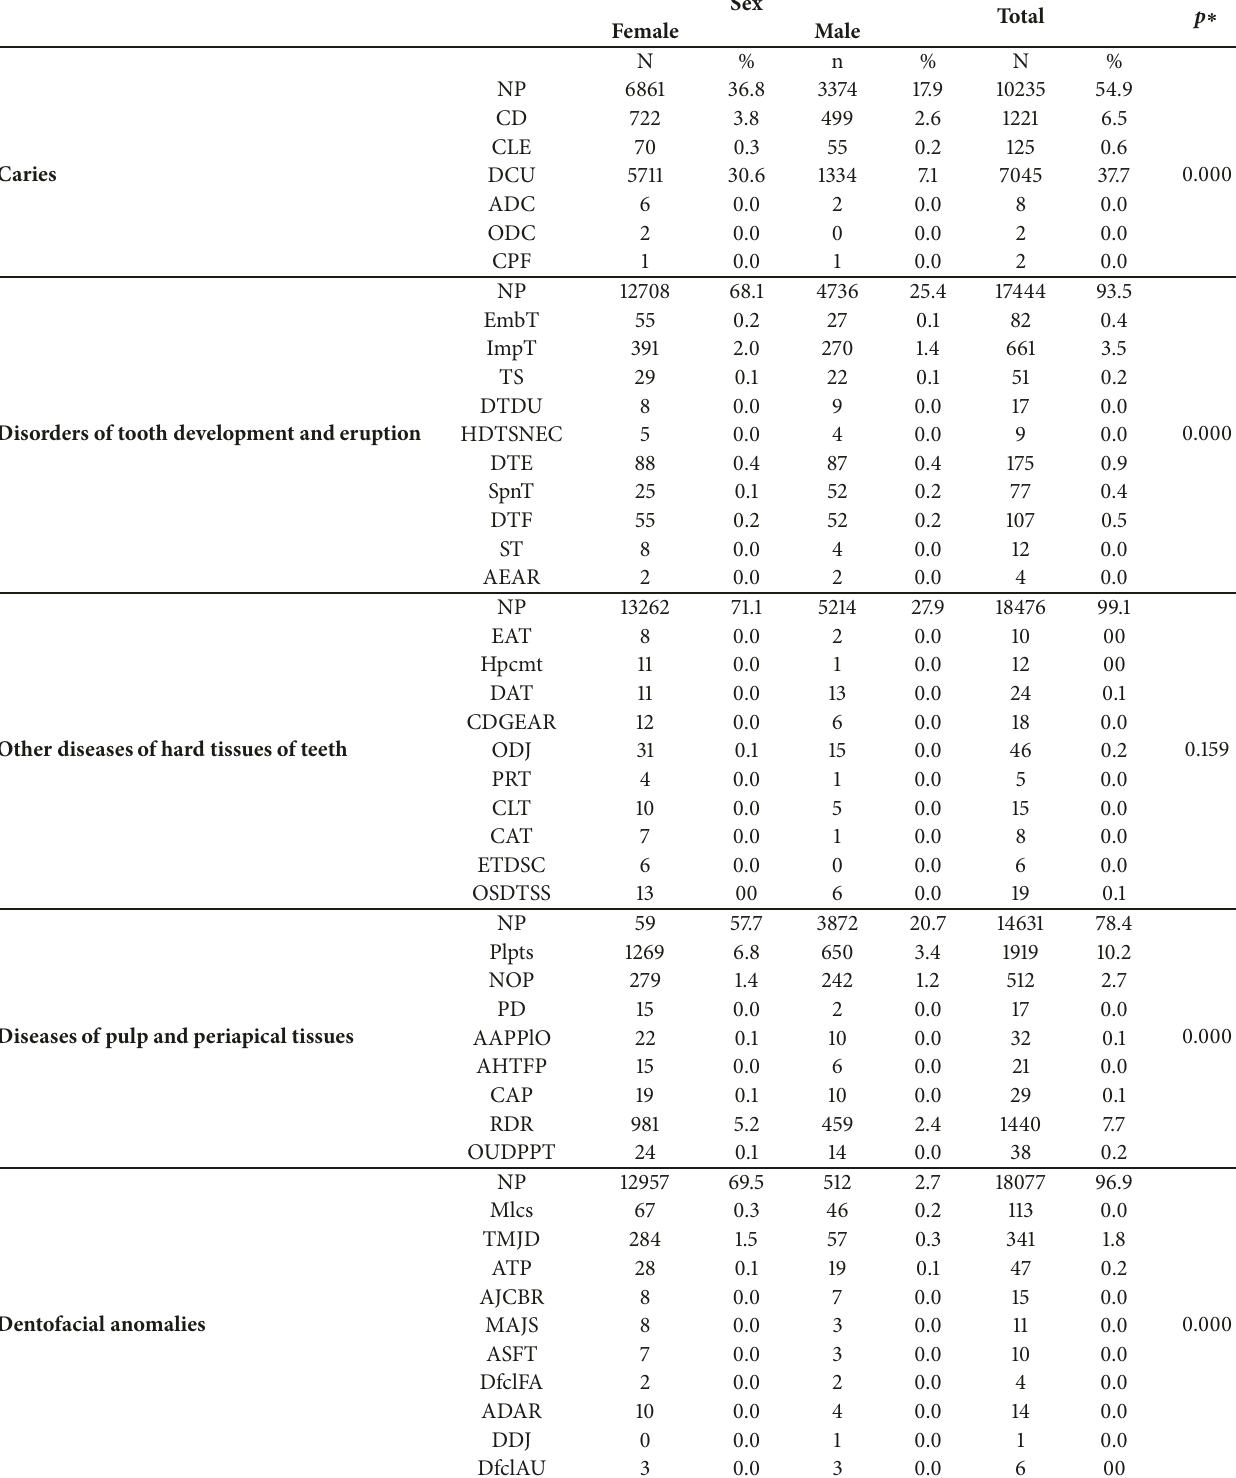
Table 2: Nine-year retrospective study of the prevalence of hard tissue